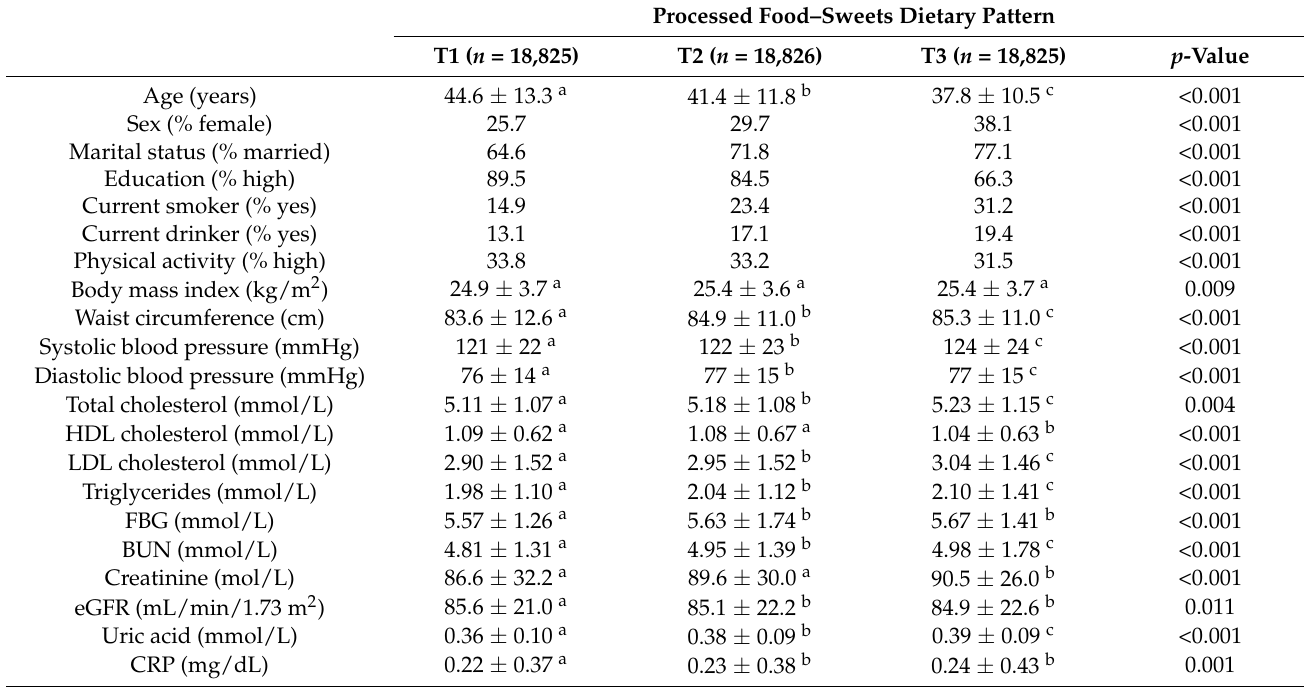
Table 3. Characteristics of the subjects across tertiles of the processed food–sweets dietary pattern ( n = 56,476) 1 . Processed Food–Sweets Dietary Pattern